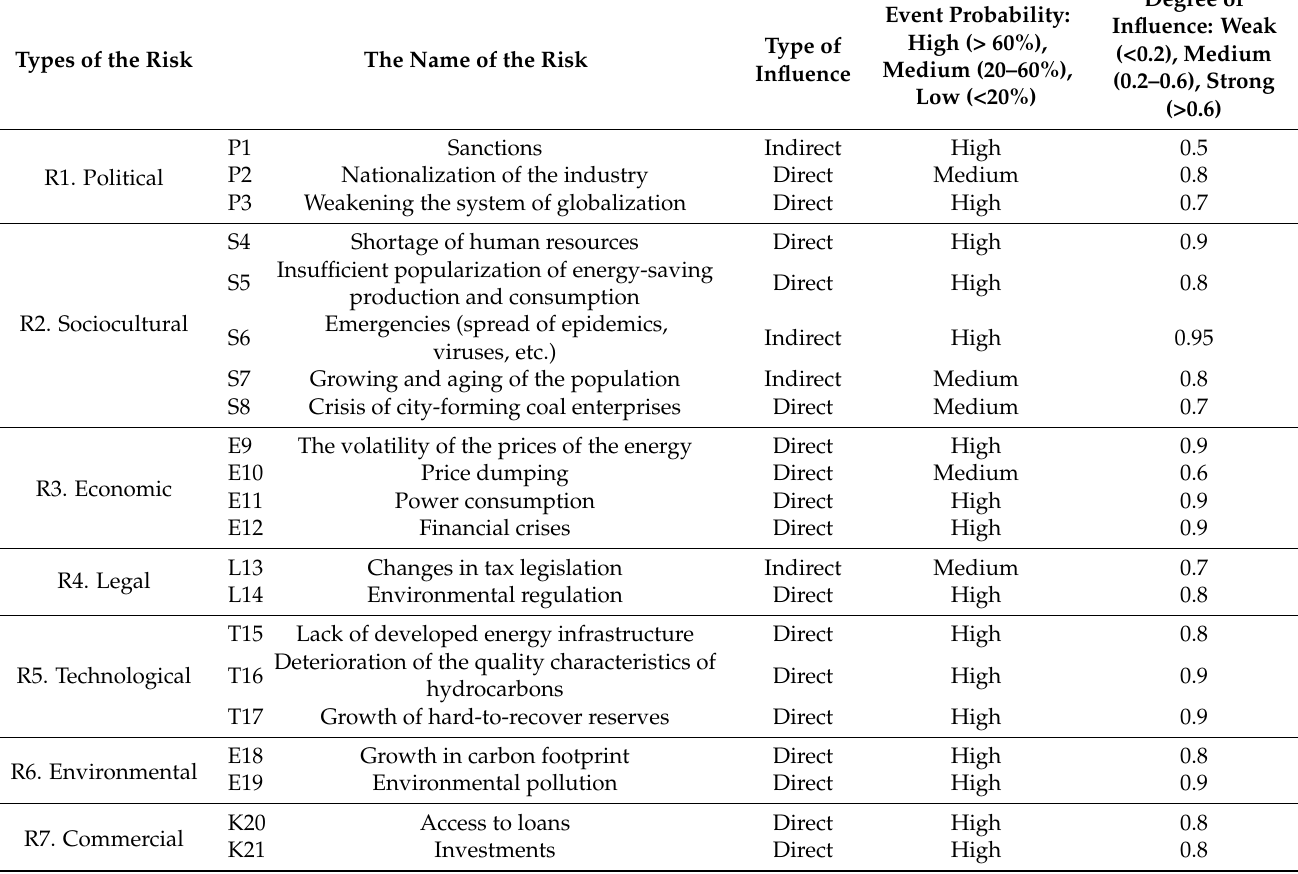
Table 2. Table 2. Global risks for fossil energy